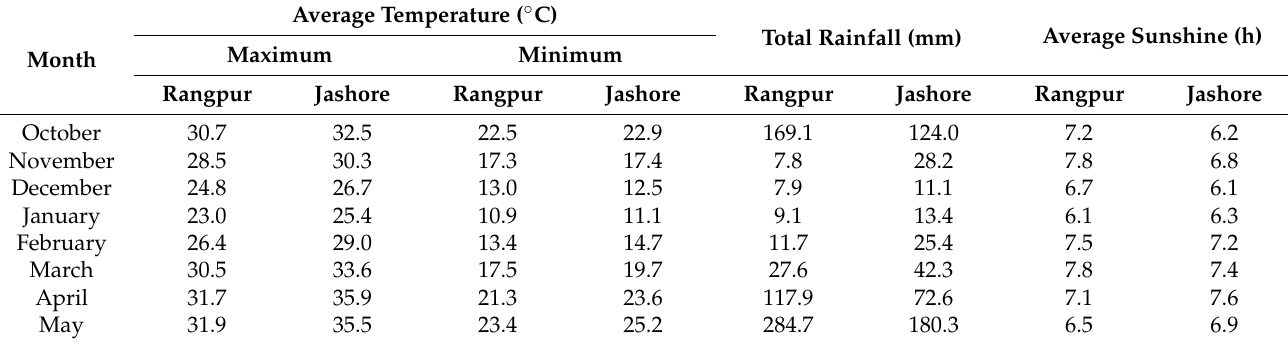
Table 1. Historical weather data of Rangpur and Jashore during the growing season of maize (average of 30